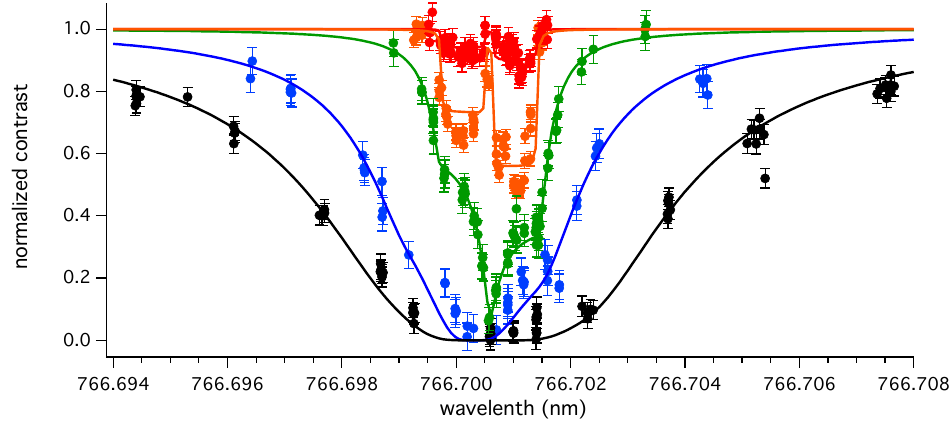
Figure 4. Decoherence spectra showing contrast as a function of wavelength. Theoretical curves based on Equation (11) with T = 3/ Γ and θ = 1.3 mrad are shown too. The laser power (hence the parameter Ω Rabi ) was deliberately varied for the different data sets. Higher irradiance results in deeper and broader contrast loss features. The red, orange, green, and black fits show a net Doppler shift of − 0.21 pm. The fit in blue shows a net Doppler shift of − 0.48 pm, but we suspect the laser power may have drifted during this data set, thus causing a spurious shift in the line center.